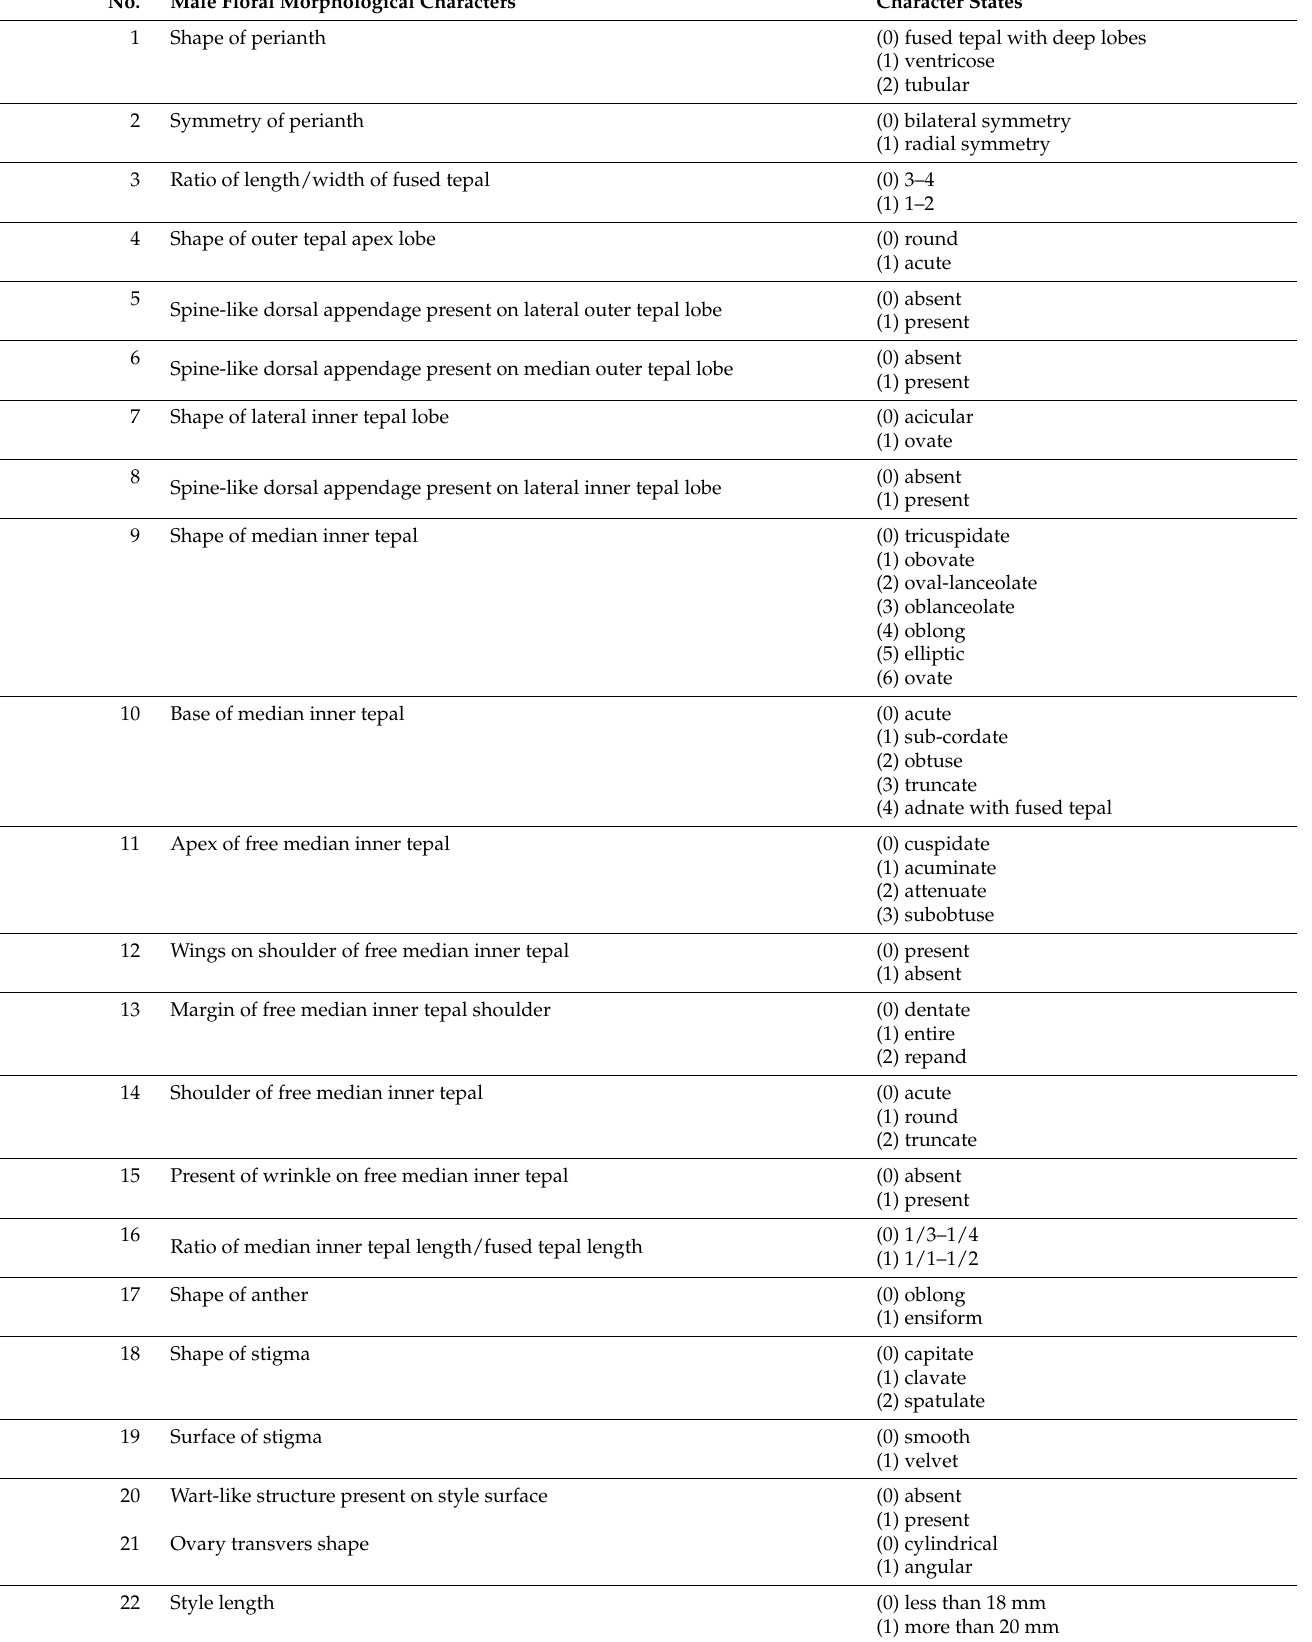
Table 5. The 22 male floral morphological characters and their states used in the